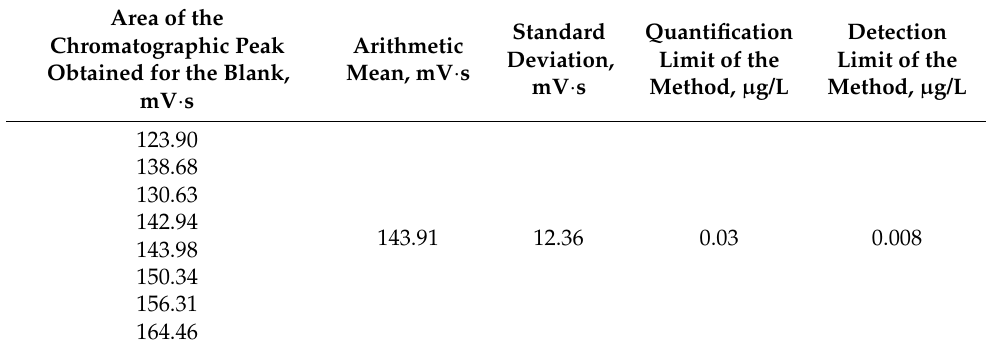
Table 5. Results of measurements and calculations obtained during the determination of the limit of detection and quantification of the chromatographic method for the determination of uranine.